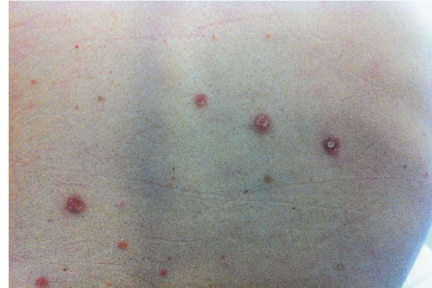
Figure 1: Generalized cutaneous erythematous maculae with distinct edges.